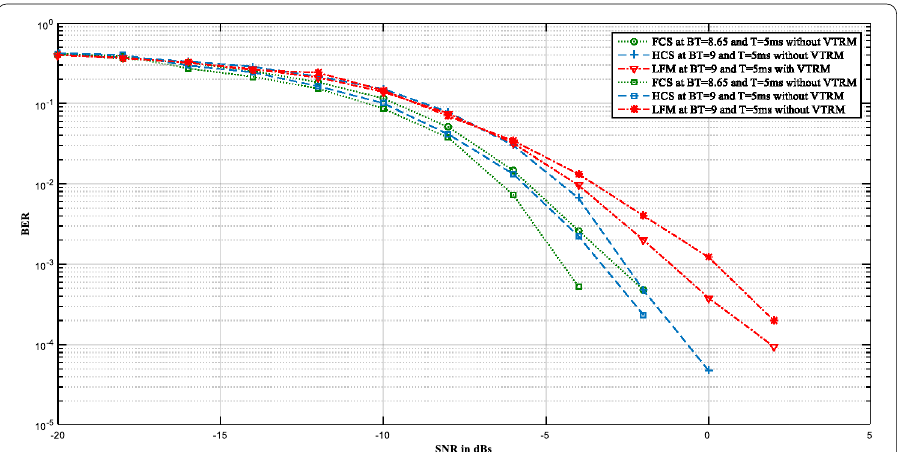
Fig. 13 BER versus SNR graph of HCS Chirp, FCS Chirp and LFM with SF 9sHz and 8.5, respectively, and Chirp Period 5 ms